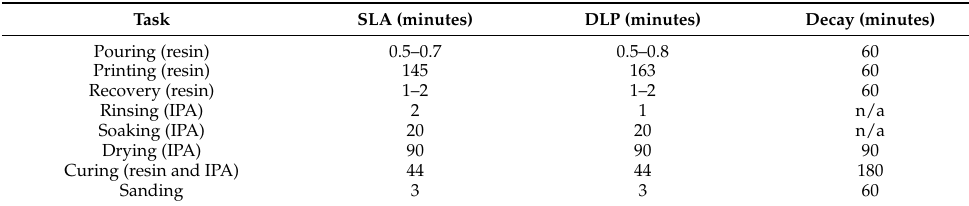
Table 1. Durations of tasks and decay periods performed during two types of vat polymerization additive manufacturing processes 1